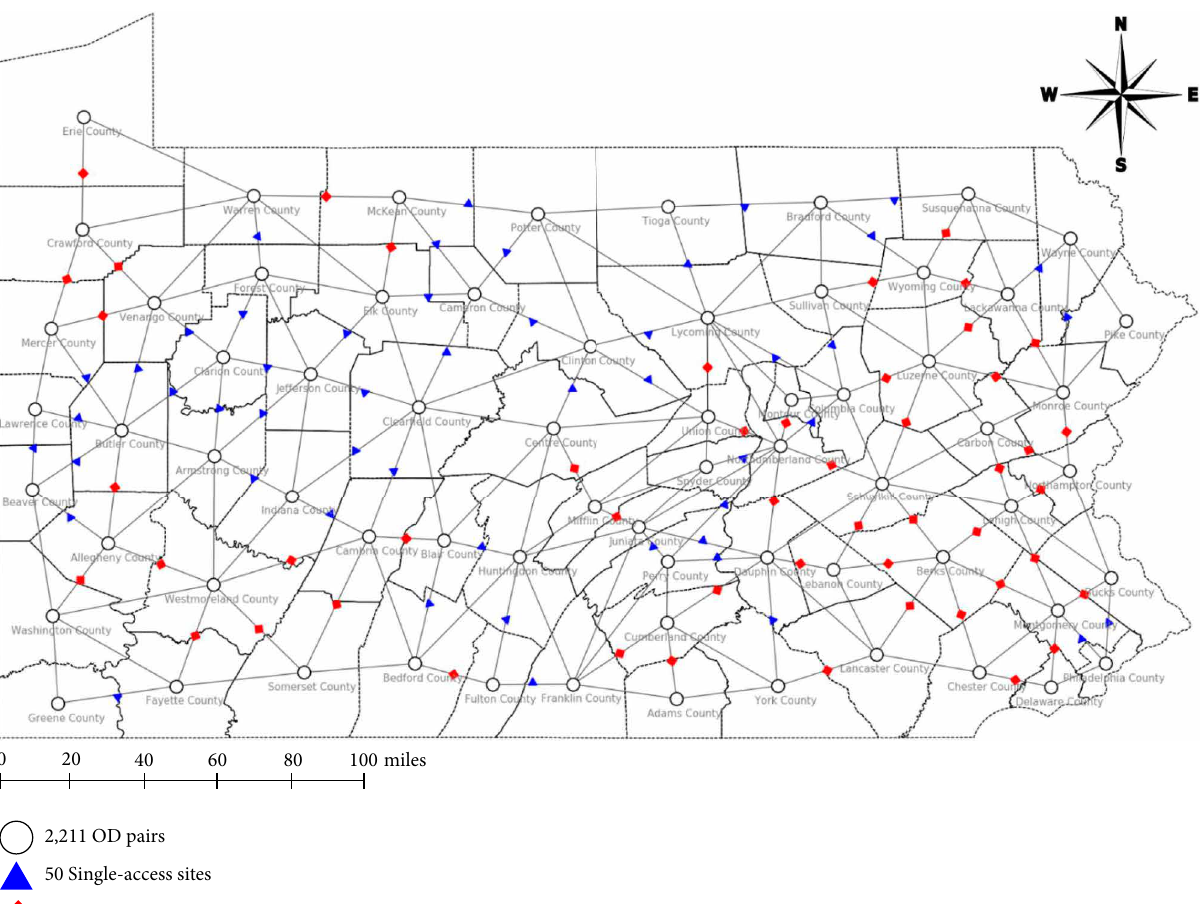
Figure 8: A road network in the state of Pennsylvania with 100 candidate sites for LNG stations.